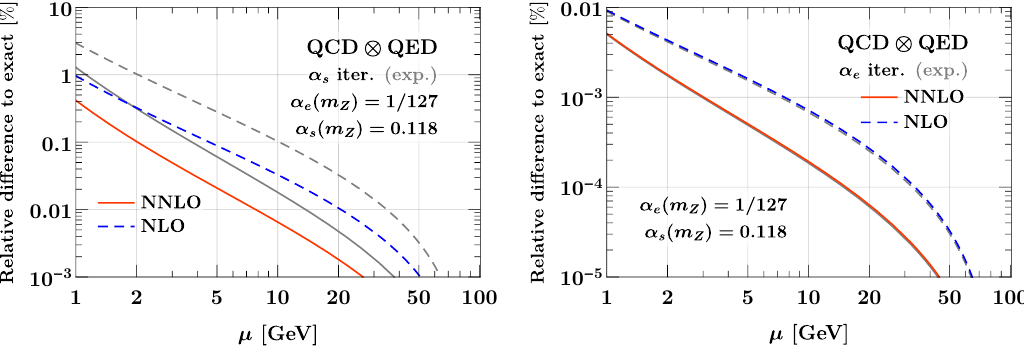
Figure 2 . Relative deviation from the exact solution for the running of the QCD (left) and QED (right) coupling constants in QCD (cid:10) QED for the iterative (colored) and expanded (gray) solutions.